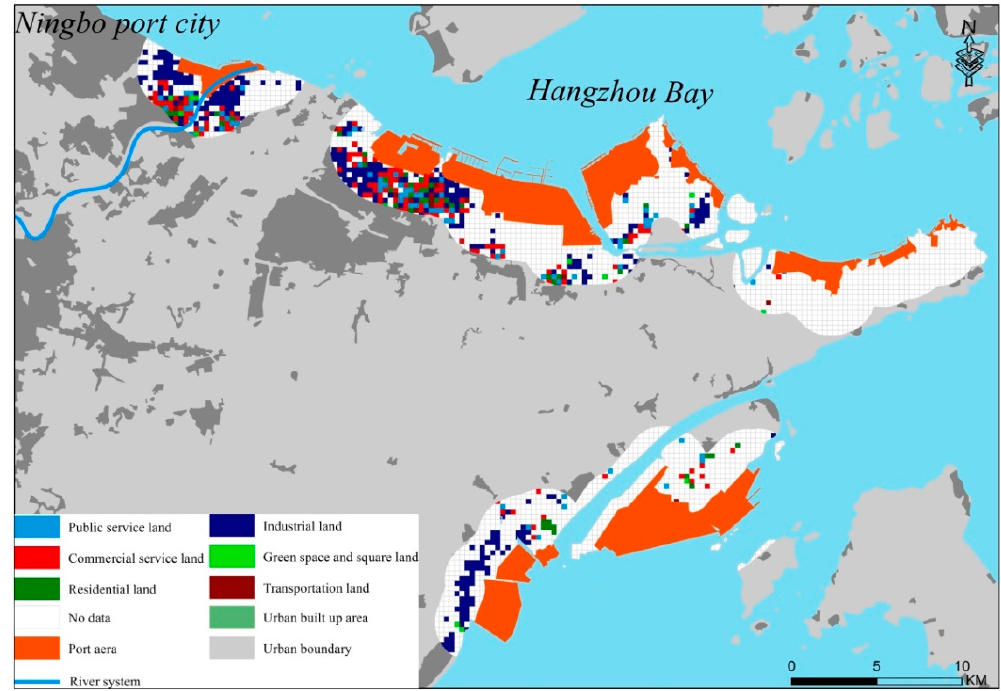
Figure 7. Distribution of urban functional areas on the Ningbo port–city interface (source: drawn by author).